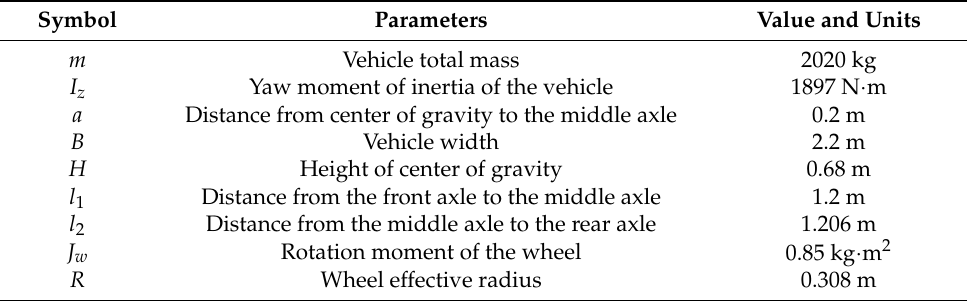
Table 1. Parameters of the experimental platform.